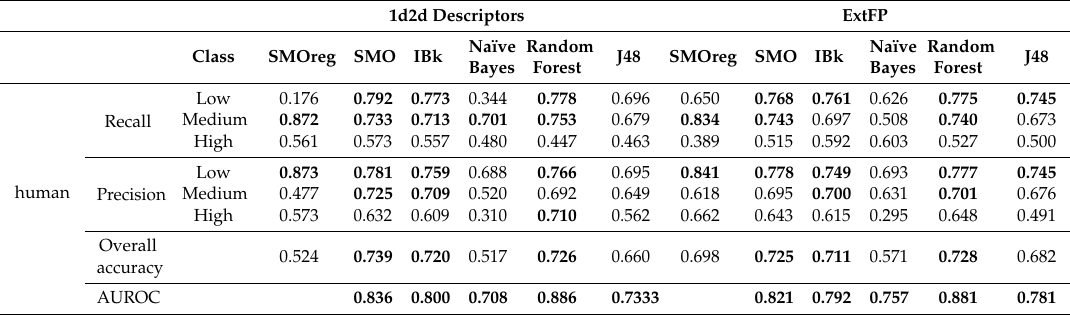
Table 4. Evaluation parameters obtained in 10-fold CV for data (T 1/2 ) produced on liver microsomes. Values above 0.7 are depicted in